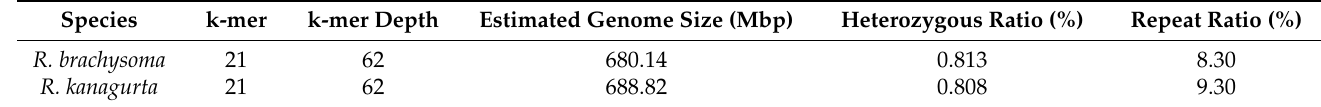
Figure 2. 21-mer analysis for estimation of the genome size of R. brachysoma and R. kanagurta . Table 1. Genome size estimation statistics based on 21-mer analysis of R. brachysoma and R. kanagurta .